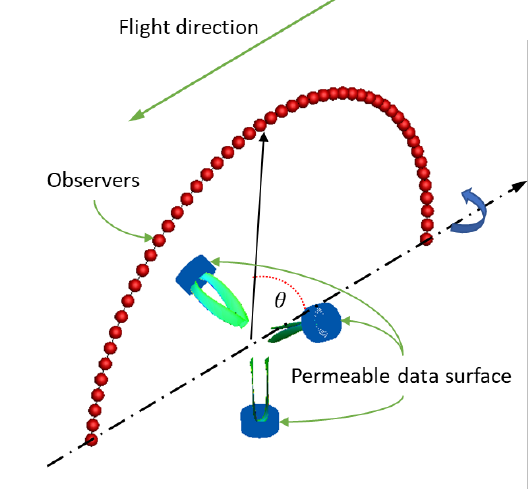
Figure 14. The placement of the permeable surfaces and the observers in the CAA computation. Boxprop is shown as an example.